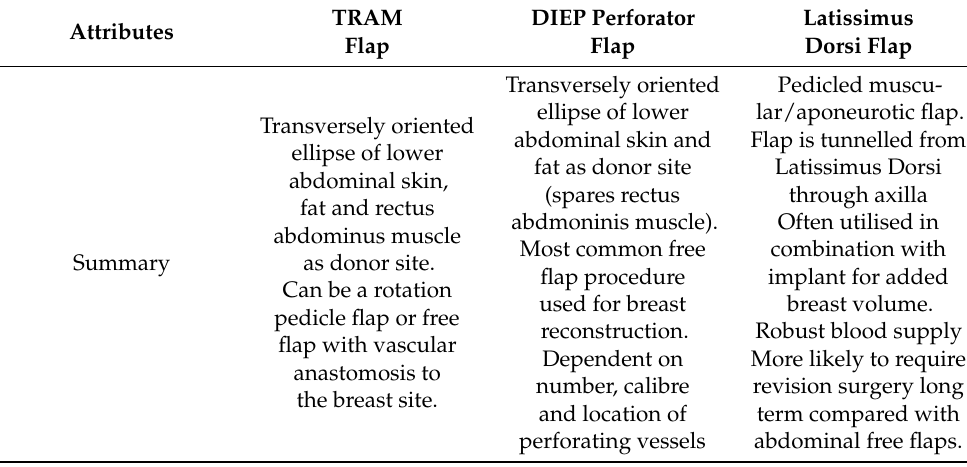
Table 2. Summary of three most common autologous reconstructive options and their